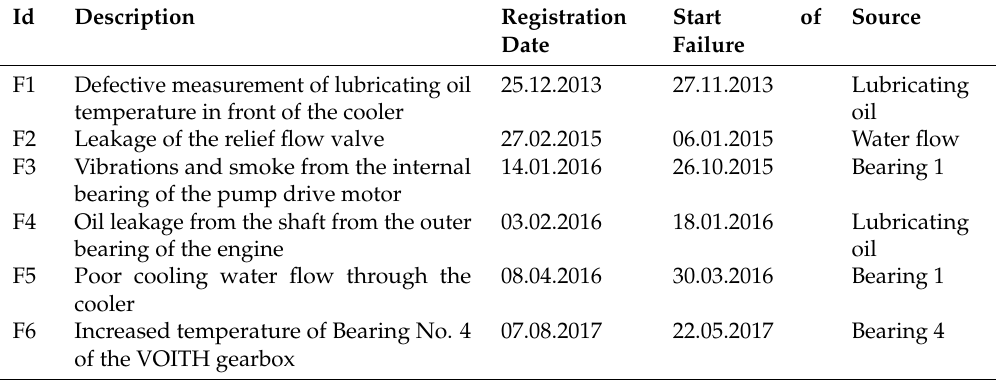
Table 4. Predicted events and time of their recording.